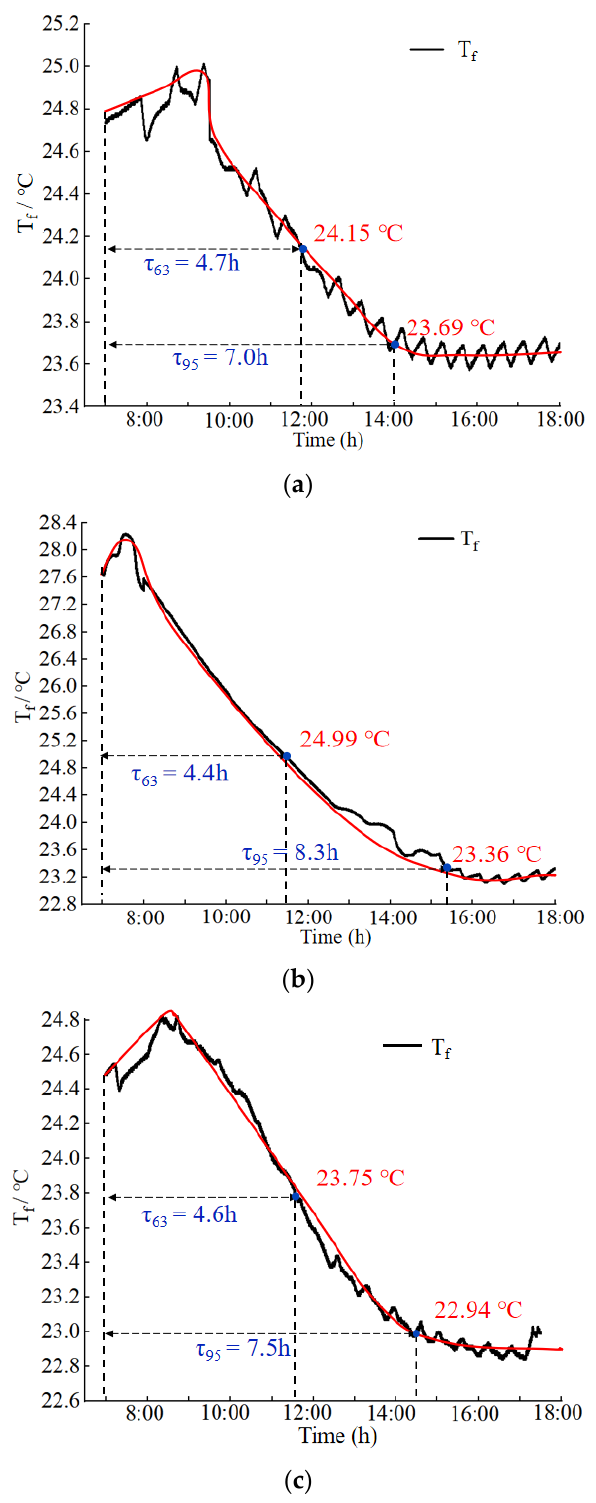
Figure 12. Temperature change of the radiant floor surface, T f change during the ( a ) LH, ( b ) HL, and ( c ) MM operating strategies.